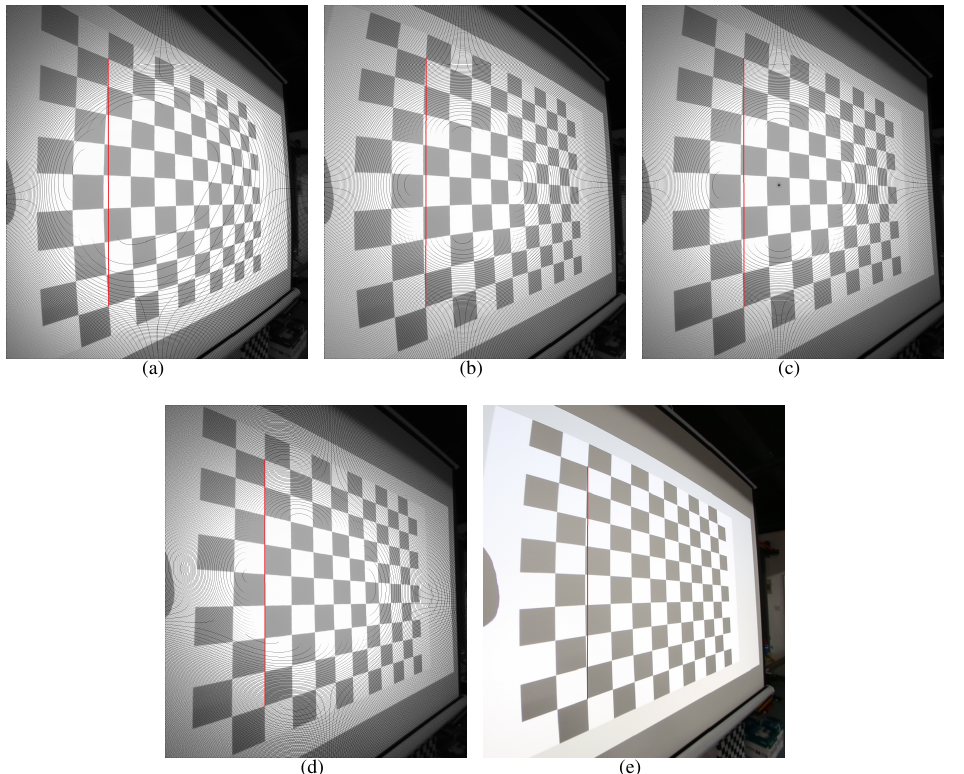
Figure 5: Results of lens correction using the RT model (a) , FET model (b), PFET model (c), RF model (d), division model (e)